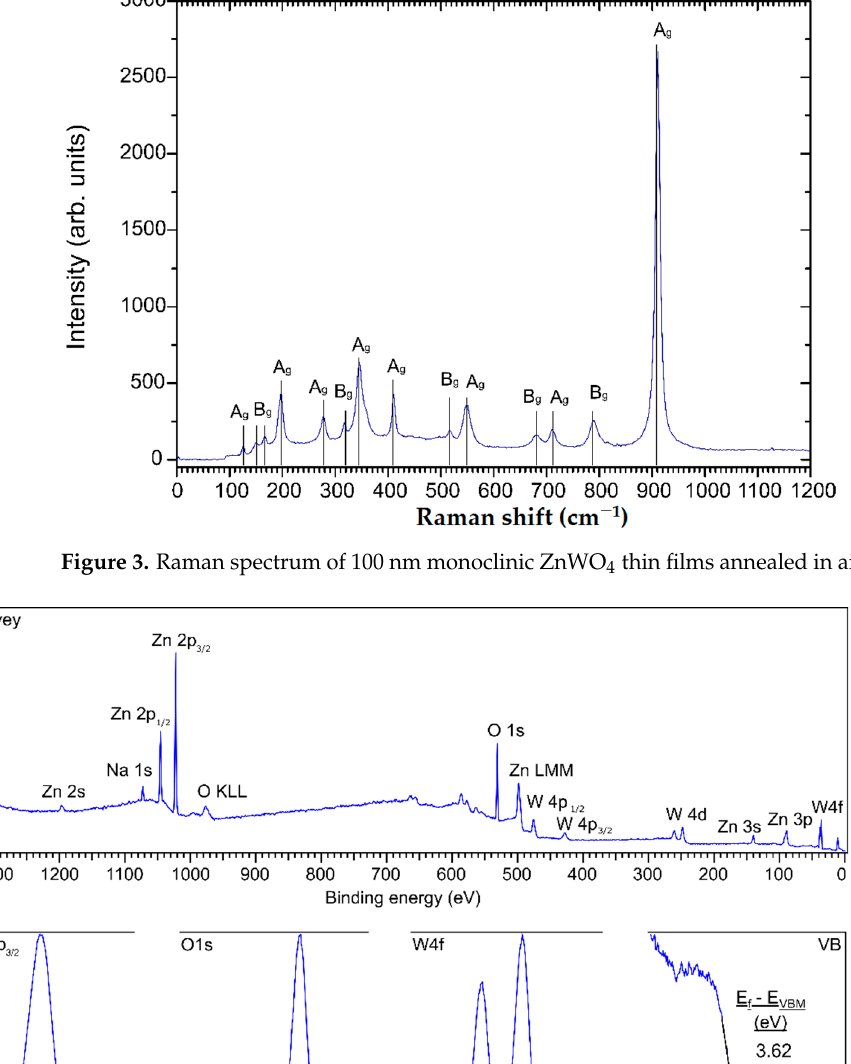
Figure 3. Raman spectrum of 100 nm monoclinic ZnWO 4 thin films annealed in air at 600 °C for 10 h.